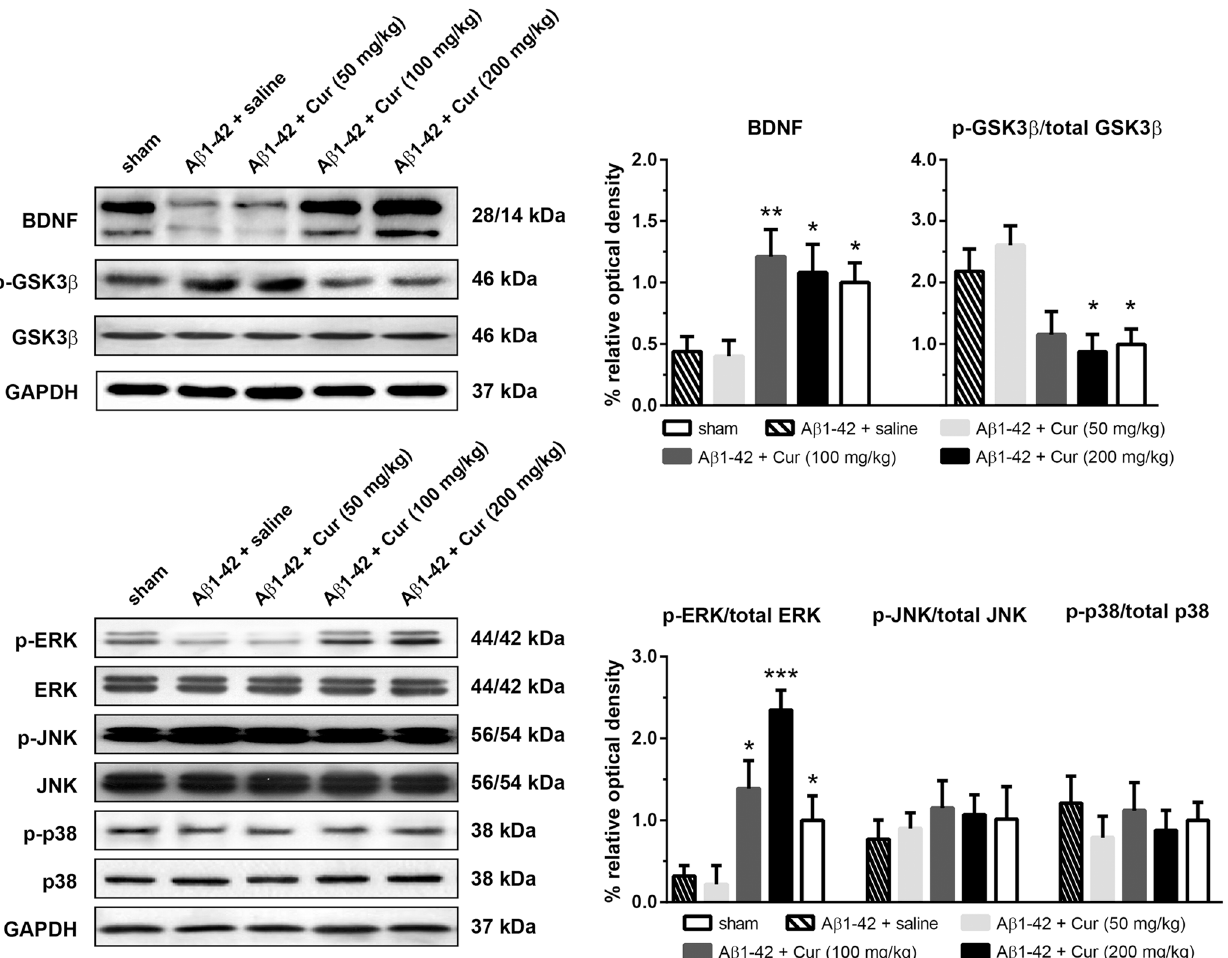
Fig 4. Effect of chronic curcumin treatment on BDNF expression and GSK3 β , MAPK phosphorylation in the hippocampus. Upper-left: representative western blots of BDNF and GSK3 β in each group. GAPDH was used as the internal loading control. Upper-right: relative expression of BDNF expression phosphorylated GSK3 β . Lower-left: representative western blots of ERK, JNK and p38 phosphorylation in each group. Lower-right: relative expression of phosphorylated ERK, JNK and p38. Protein phosphorylation was expressed as phosphorylated form vs. total protein. * P < 0.05 and ** P < 0.01 compared with A β 1 – 42 +